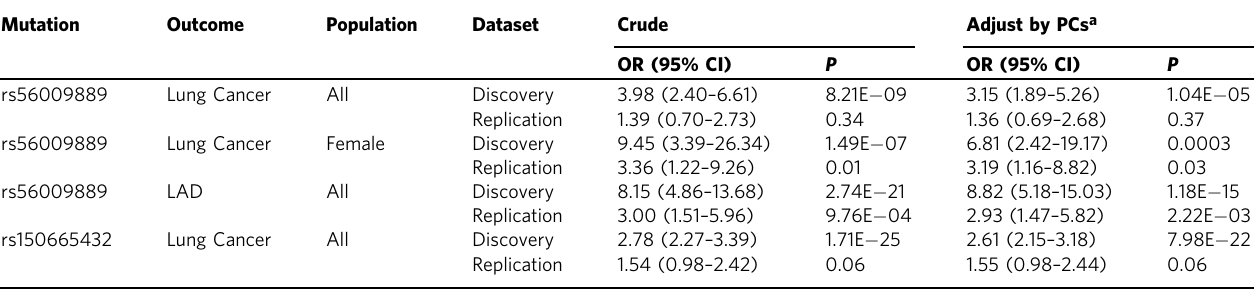
Table 1 Allele-speci fi c lung cancer risk for ATM-L2307F (rs56009889) and KIAA0930-Q4X (rs150665432). Mutation